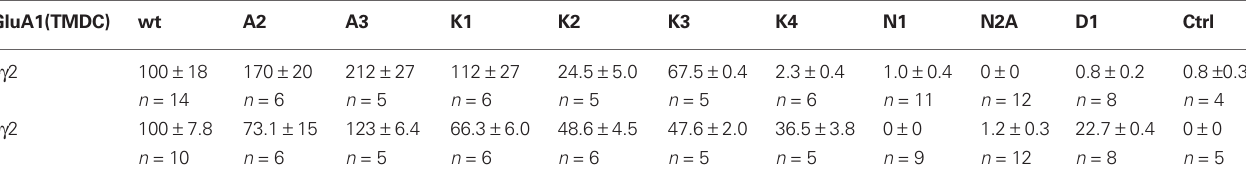
Table 1 | Normalized kainate-induced currents of all generated chimeras in presence and absence of the TARP γ 2, all values in % ± SeM.